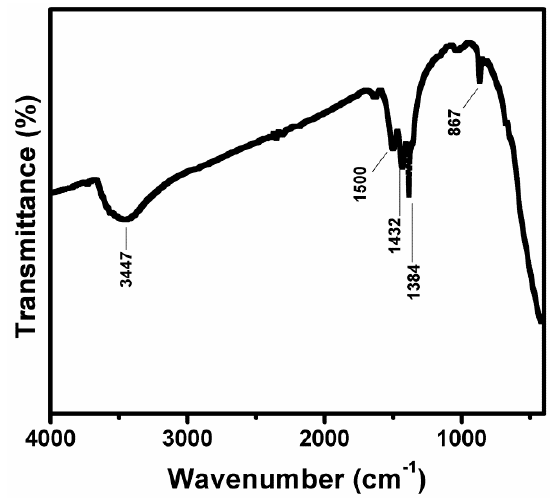
Figure 3. Fourier Transformed Infra-Red (FTIR) spectra of ternary metal oxides obtained from flame-assisted spray pyrolysis using 1 M precursor solution.